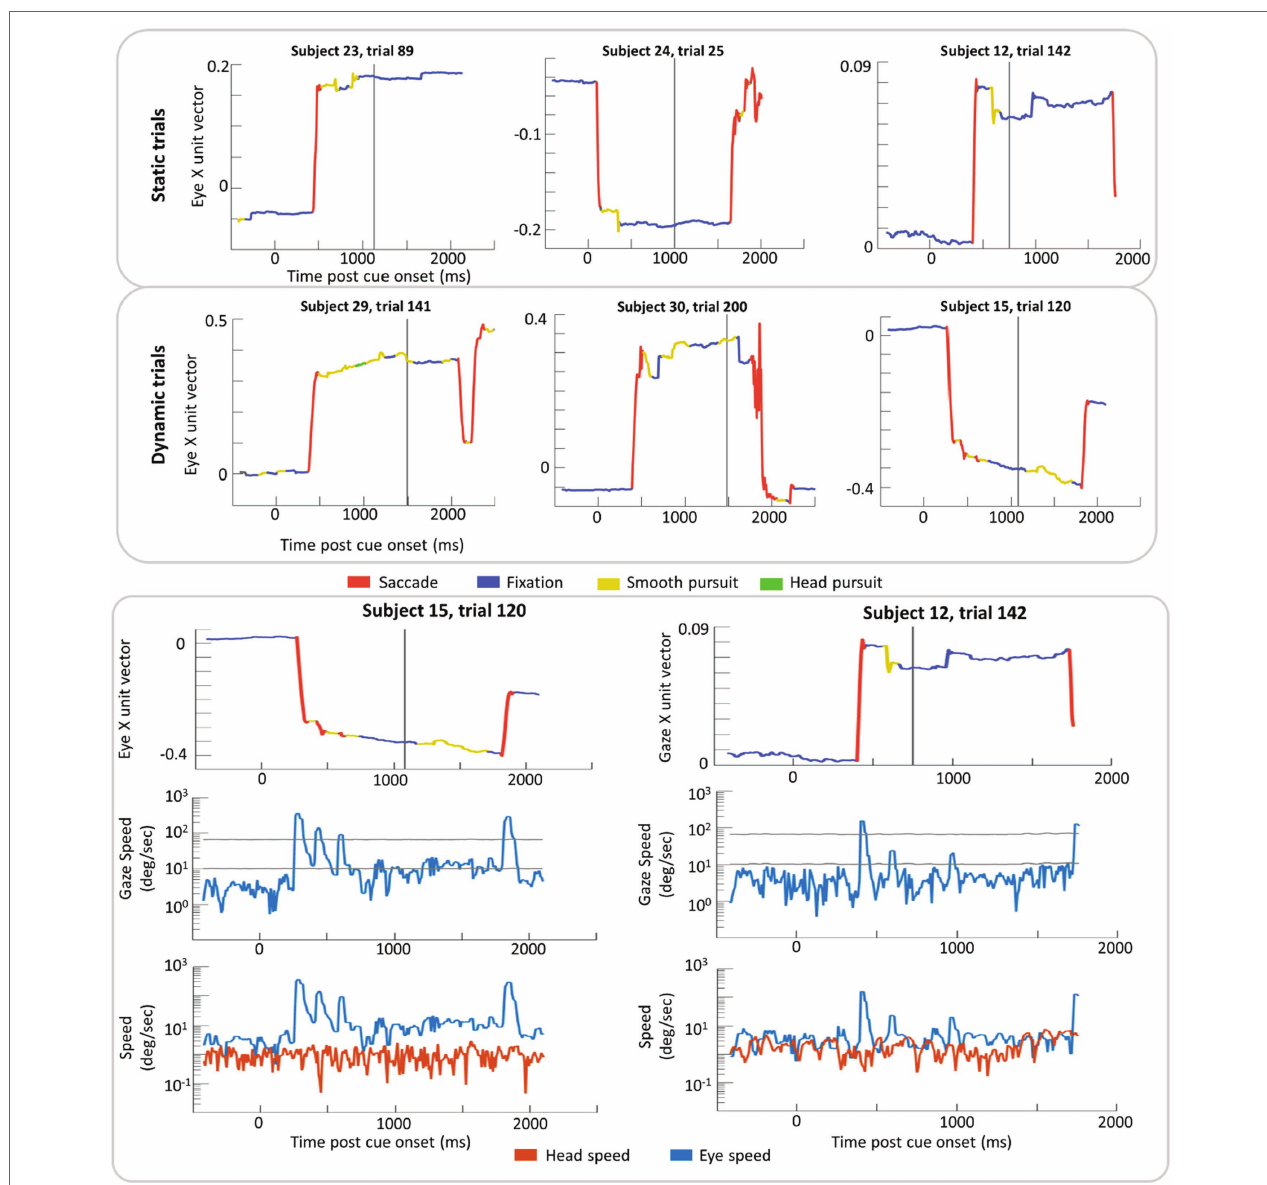
FIGURE 6 | Example trial plots of the eye unit vector along the x-axis for Static and Dynamic trials (top section). In the bottom section, two trials from the top (subject 15, trial 120 and subject 12, trial 142) have been expanded to include the log linear transform of gaze speed plotted with scaled high and low thresholds (grey lines) in addition to the log linear transform of eye and head speed (bottom row). These transformations were done in order to plot instances of high speed without losing detail in slower speed time periods. In each graph, time zero marks the time of the cue (yellow disk) onset and the grey vertical line indicates the time the target was presented. Red lines indicate time windows labeled saccade and blue lines indicate time windows labeled fixation. Yellow and green lines indicate windows in of smooth pursuit and head pursuit,